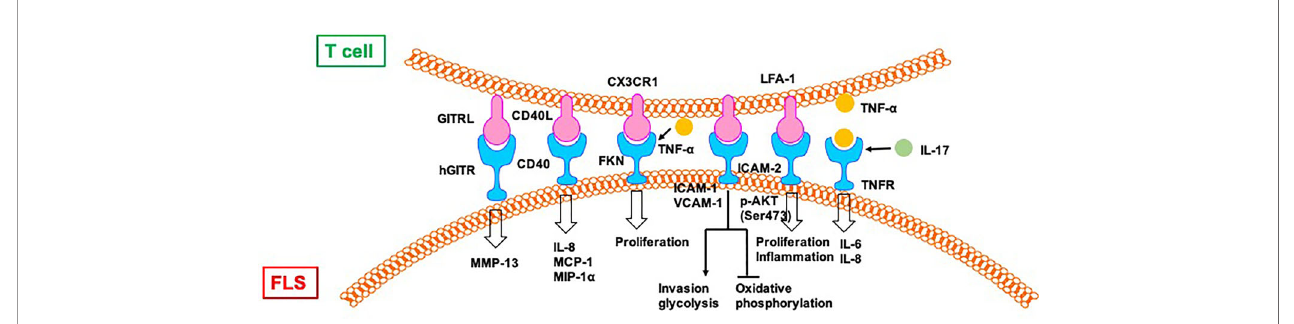
FIGURE 5 | T cells directly regulate FLS in RA. CII:type II collagen; FKN, Fractalkine;